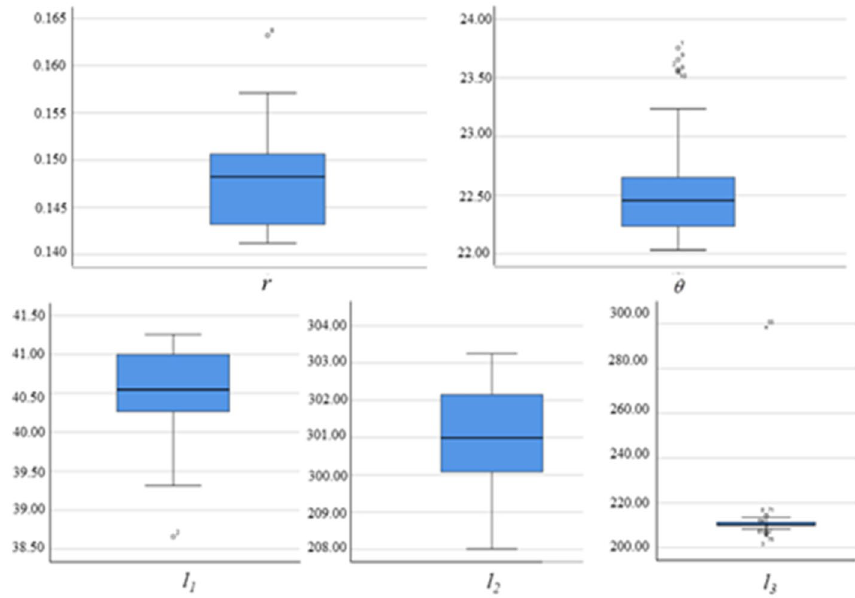
Figure 4. Data analysis of corresponding ore belt